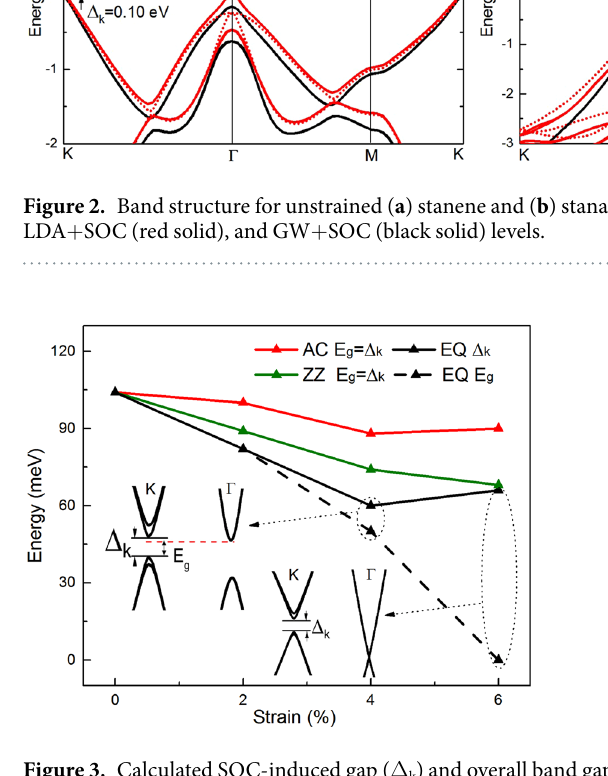
Figure 3. Calculated SOC-induced gap ( Δ k ) and overall band gap ( E g ) of stanene as fractions of biaxial strain along EQ direction, uniaxial strain along AC and ZZ directions. The two inserted figures represent the band structure of stanene under EQ 4% and 6% strain from GW